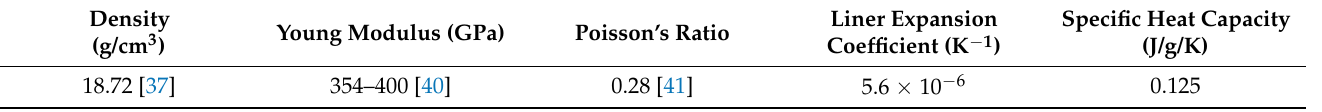
Table 1. Material parameters of fine-grained pure tungsten materials.